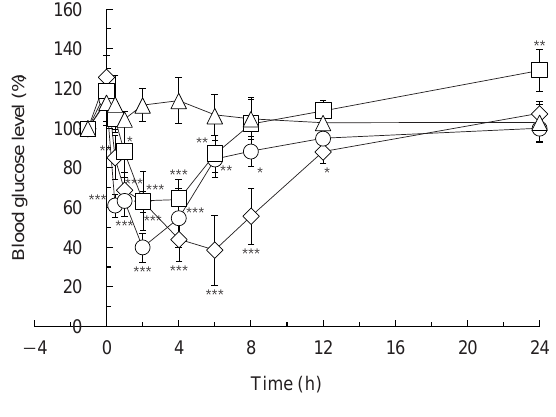
Change of blood glucose levels by different insulin administration methods ( (cid:1) ): Composite particles with insulin encapsulated PLGA nanospheres, ( (cid:2) ): intra- venous administered insulin solution, ( (cid:3) ): intratracheally administered insulin solution, ( (cid:4) ): intratracheally admin- istered saline solution as control group. Dose of insulin: 3.0 IU/rat. N (cid:3) 6, significantly different from control group ( * p (cid:5) 0.05, ** p (cid:5) 0.01, *** p (cid:5) 0.001, student t-test).